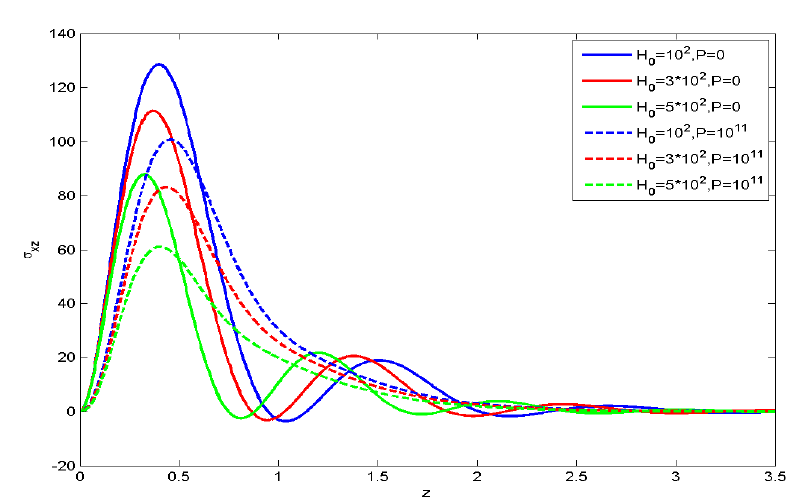
Figure 21. Normal stress σ zz concerning z with magnetic field H 0 .